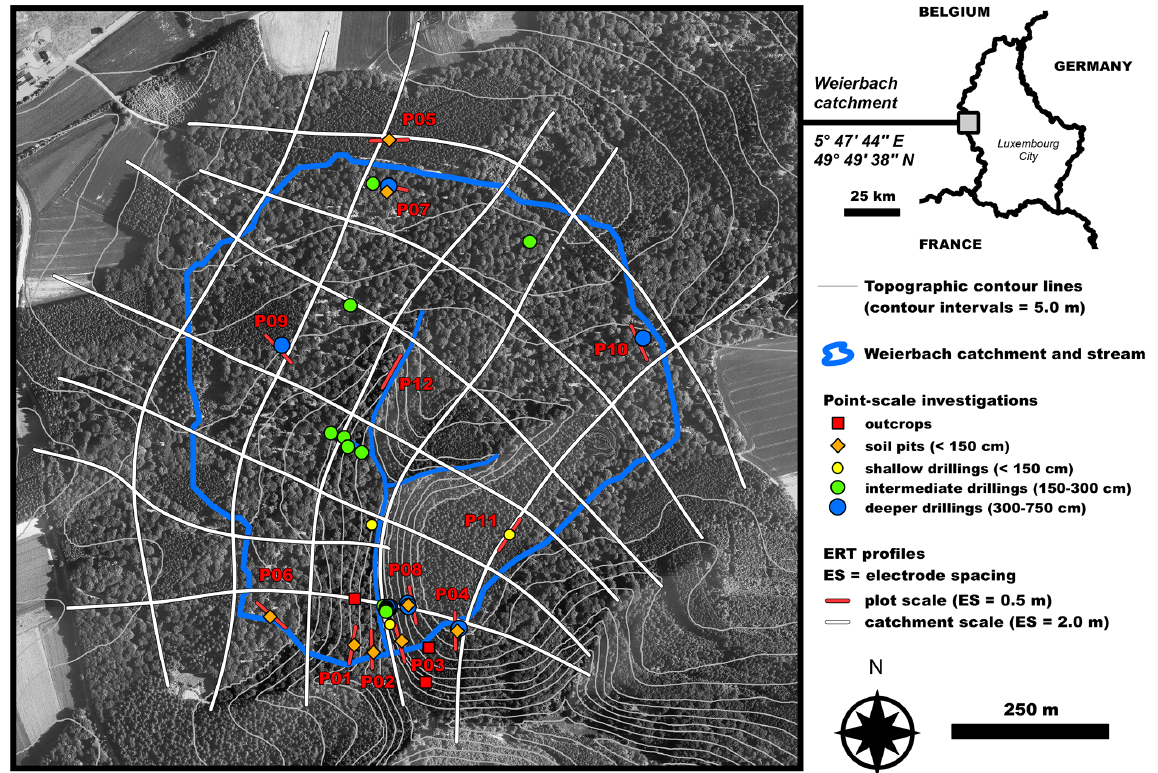
Figure 1. Detailed map of topography and investigations made in the Weierbach catchment (background aerial photography from Adminis- tration du Cadastre et de la Topographie, Luxembourg